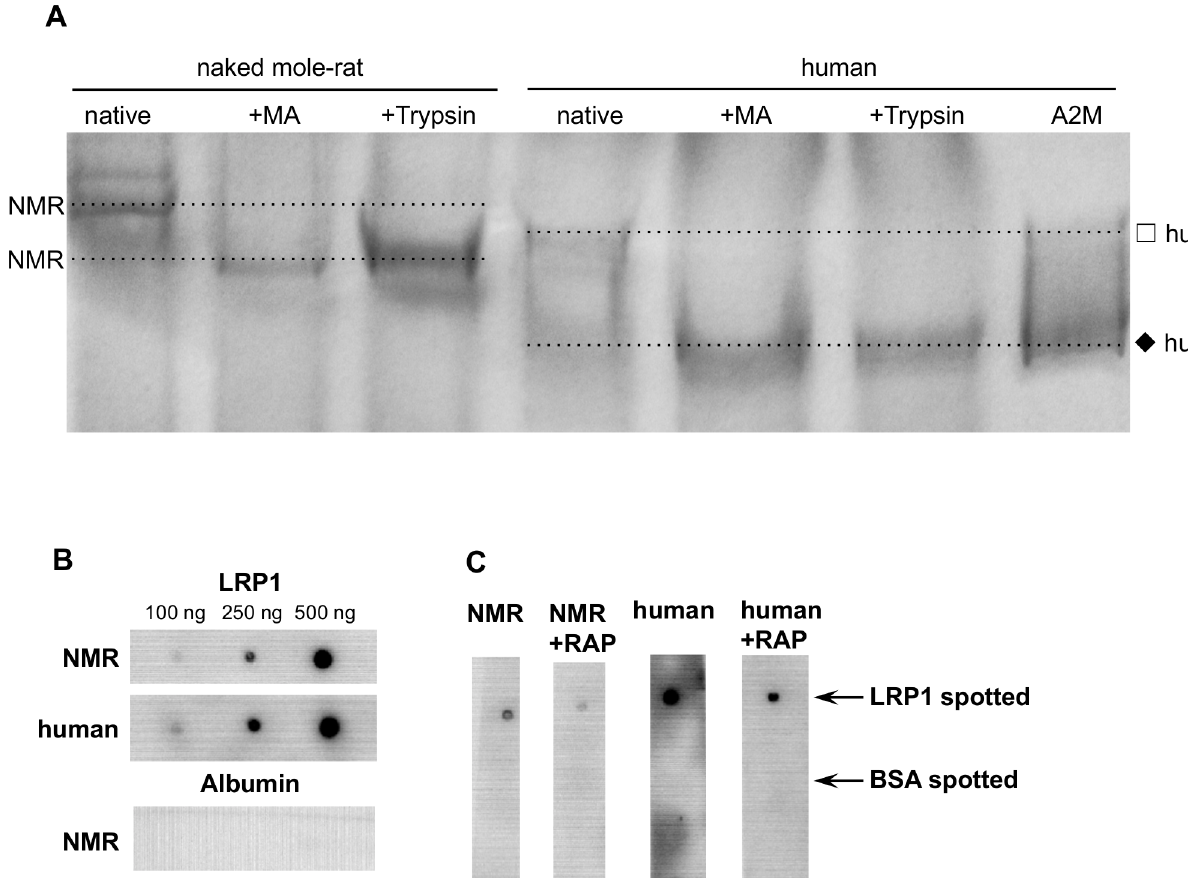
Fig 3. RATE electrophoresis of NMR and human plasma and analysis of the receptor-binding properties of their A2M. RATE electrophoresis was done using 50 μ g native NMR and human plasma and 50 μ g of methylamine and trypsin treated plasma, respectively. Isolated human A2M served as control. Methylamine as well as trypsin shift human and NMR-A2M from the slow- to the fast-moving form. To visualize the respective protein bands the gel was stained with Commassie (A). Purified LRP1 (100 – 500 ng) was spotted to a nitrocellulose membrane and incubated with either 10 μ g/mL human or NMR plasma. BSA served as negative control. A2M binding to LRP1 was detected by a polyclonal rabbit anti-human A2M antibody (5 μ g/mL) (B). To block the binding of A2M to LRP1 the spotted LRP1 was pre-incubated with 1.5 μ M RAP for 30 min prior to the addition of human or NMR plasma (C). ( ☐ - native/slow form of A2M, ◆ – transformed/fast form of